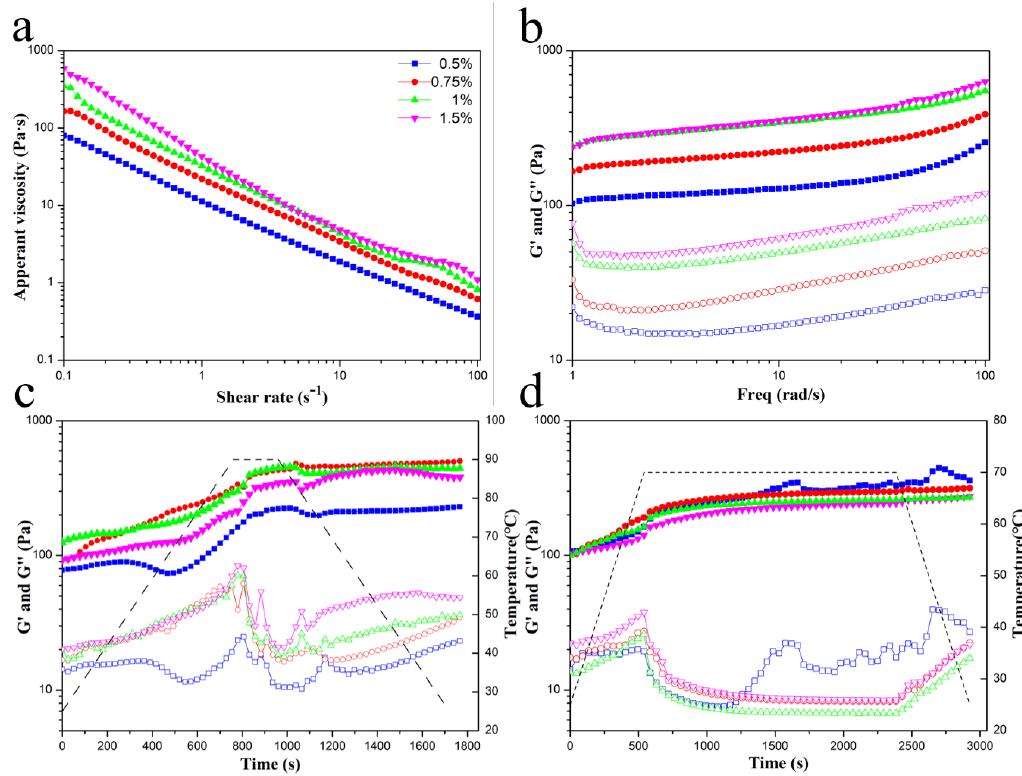
Figure 2. Rheological properties of GNPs Pickering emulgels at different concentrations (0.5%−1.5%, w / v ). ( a ) Apparent viscosity versus shear rate, ( b ) oscillatory frequency sweep curves, ( c ) oscillatory higher temperature short-term sweep measurement curves held at 90 ◦ C for 3 min; ( d ) oscillatory lower temperature long-term sweep measurement curves held at 70 ◦ C for 30 min. Solid and hollow symbols denote G′ and G′′, respectively. Table 1. The apparent viscosity (η), consistency index ( k ), and flow behavior index ( n ) of Pickering emulgels with gliadin nanoparticles (GNPs) concentration.